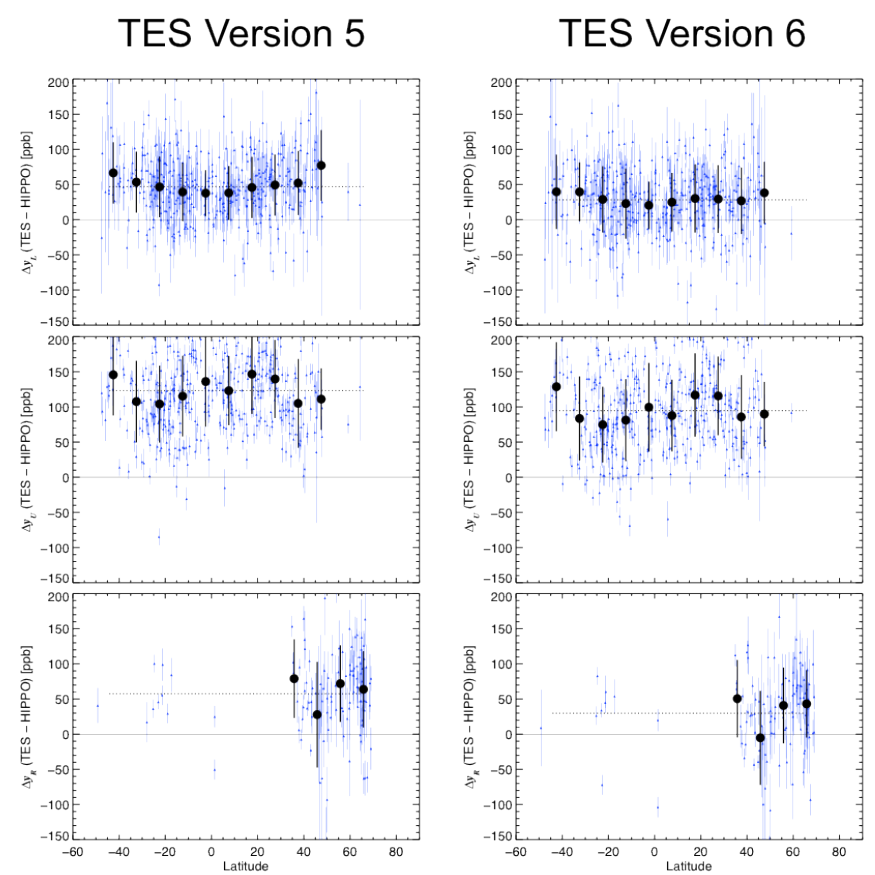
Figure 4. Latitudinal profiles of the differences between the uncorrected TES CH 4 retrievals and HIPPO CH 4 measurements for all five HIPPO campaigns. The left column has the results for TES Version 5, and the right column has the results for TES Version 6. The top two panels of each column show the results for the upper and lower tropospheric representative volume mixing ratios ( (cid:49)y L and (cid:49)y U , respectively) for TES retrievals where the degrees of freedom for signal (DOFS) is ≥ 1 . 6. The bottom panel shows the results for the RTVMR ( (cid:49)y R ) in scenes where the DOFS is < 1 . 6. The blue triangles are the differences for the individual TES retrievals, with blue lines showing the estimated retrieval error. The black circles show the mean bias for the scans binned by 10 ◦ latitude, while the black error bars are the standard deviation in each bin. Circles are only plotted when at least 10 scans are in a